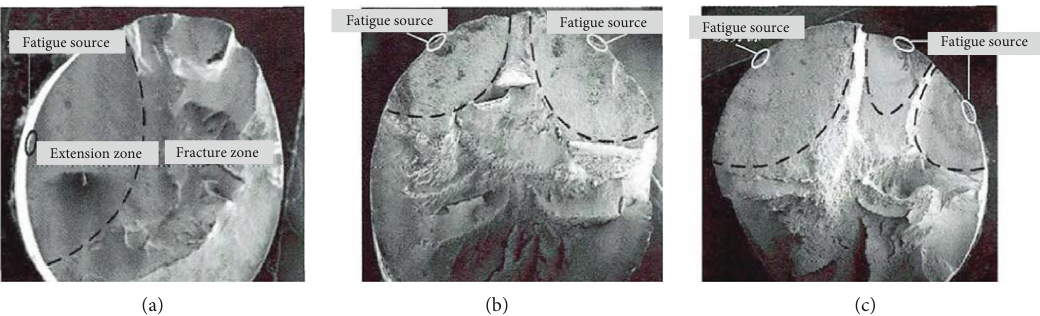
Figure 17: SEM scanning diagram of the CF fracture surface of steel wires [8]: (a) the single fatigue source; (b) the planar multifatigue sources; (c) the stepped multifatigue